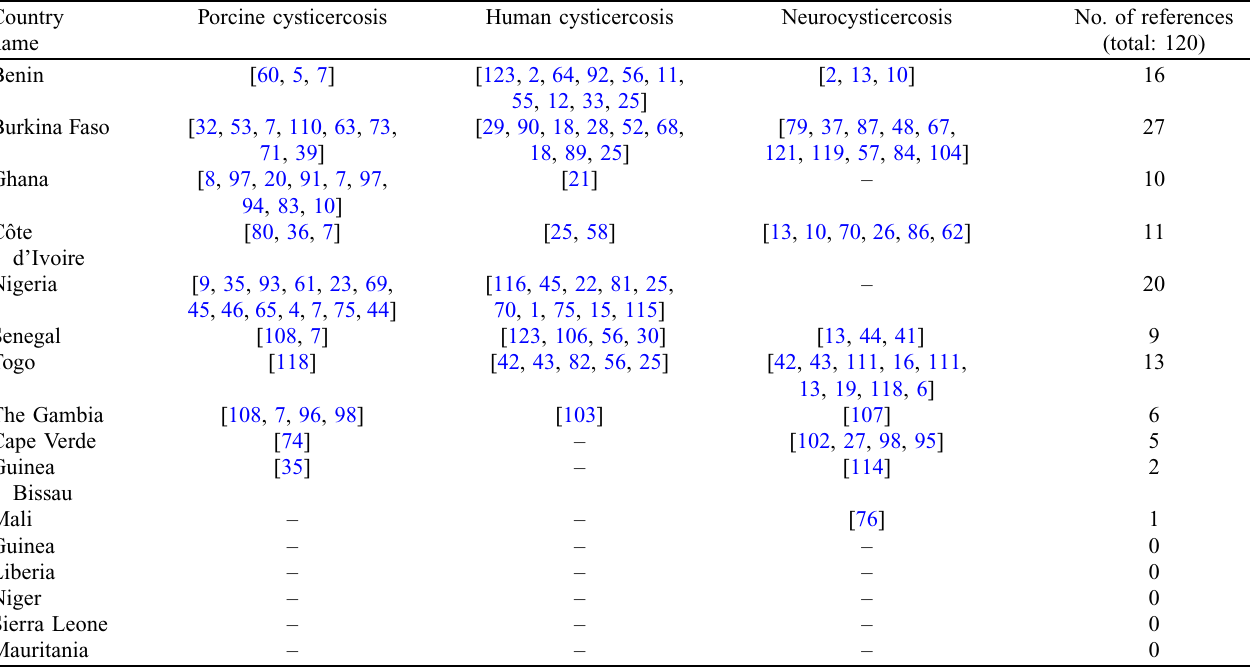
Table 1. Summary of publications available (case reports and epidemiological studies).